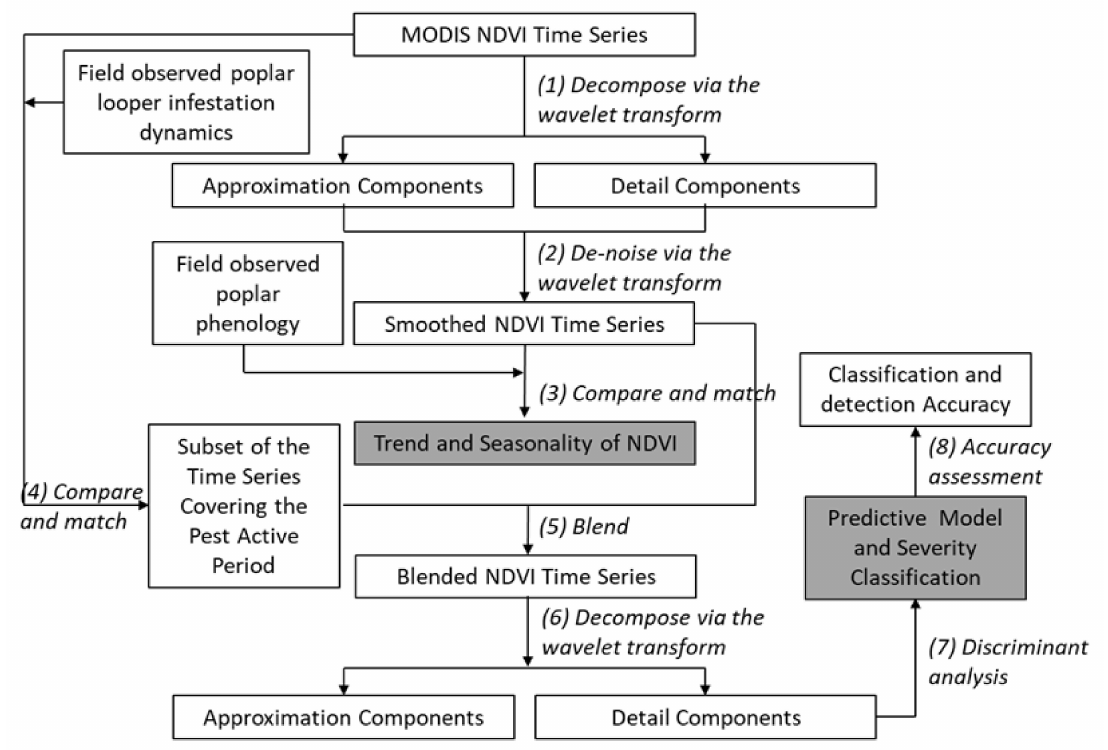
Figure 4. Methodology for the detection and severity assessment of poplar looper